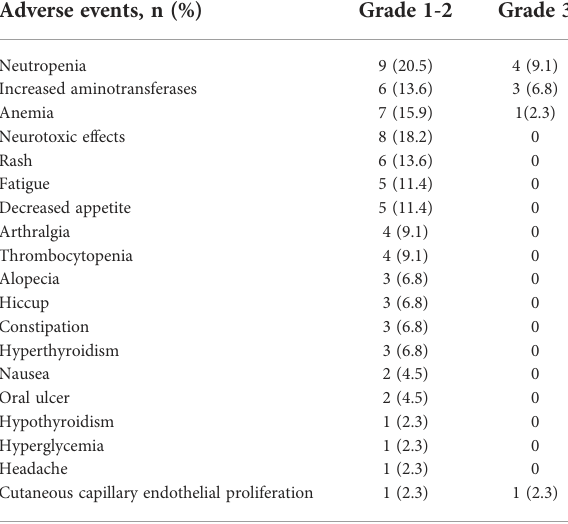
TABLE 2 Treatment-related adverse events of neoadjuvant chemoimmunotherapy. Adverse events, n (%)